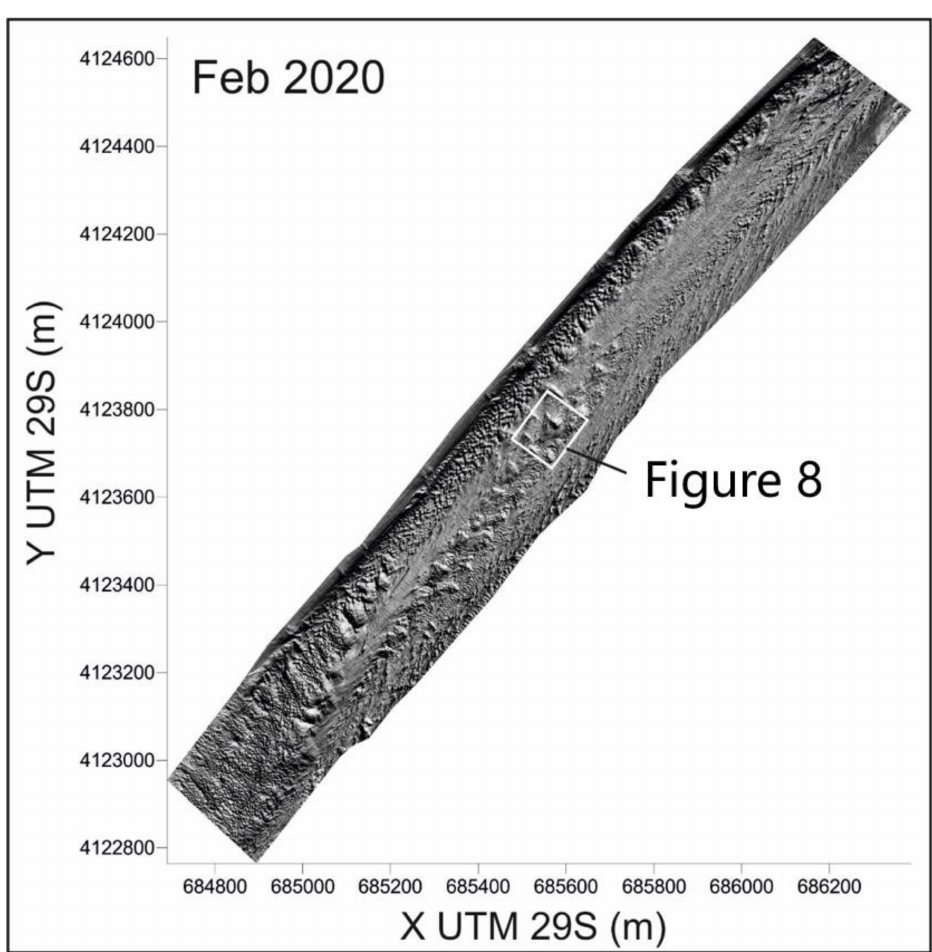
Figure 7. Shaded relief from multibeam bathymetric data from February 2020. The position of the conical morphology shown in Figure 8 is indicated.